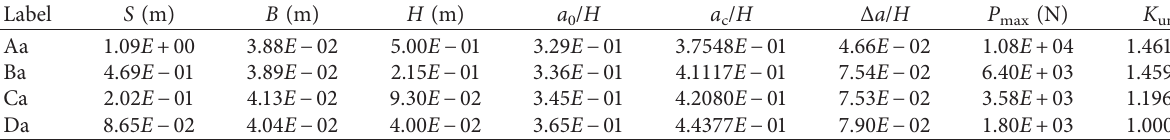
) – ( A ∗ ) for / A ∗ / A ∗ 3 1 19 1